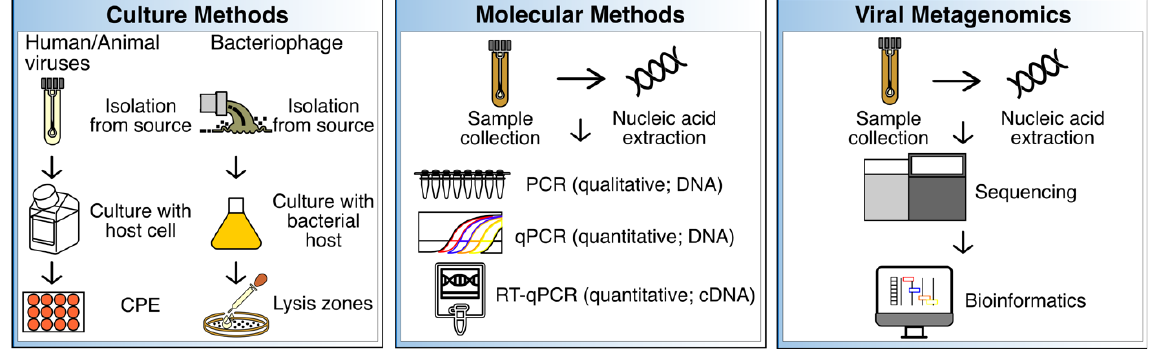
Figure 1. Summary of culture, molecular, and viral metagenomic methods. These methods have been benchmarked to track sources of fecal contamination in various sample types (see text). CPE = cytopathogenic effects; qPCR = quantitative PCR; RT-qPCR = reverse transcription qPCR; cDNA = complementary DNA.